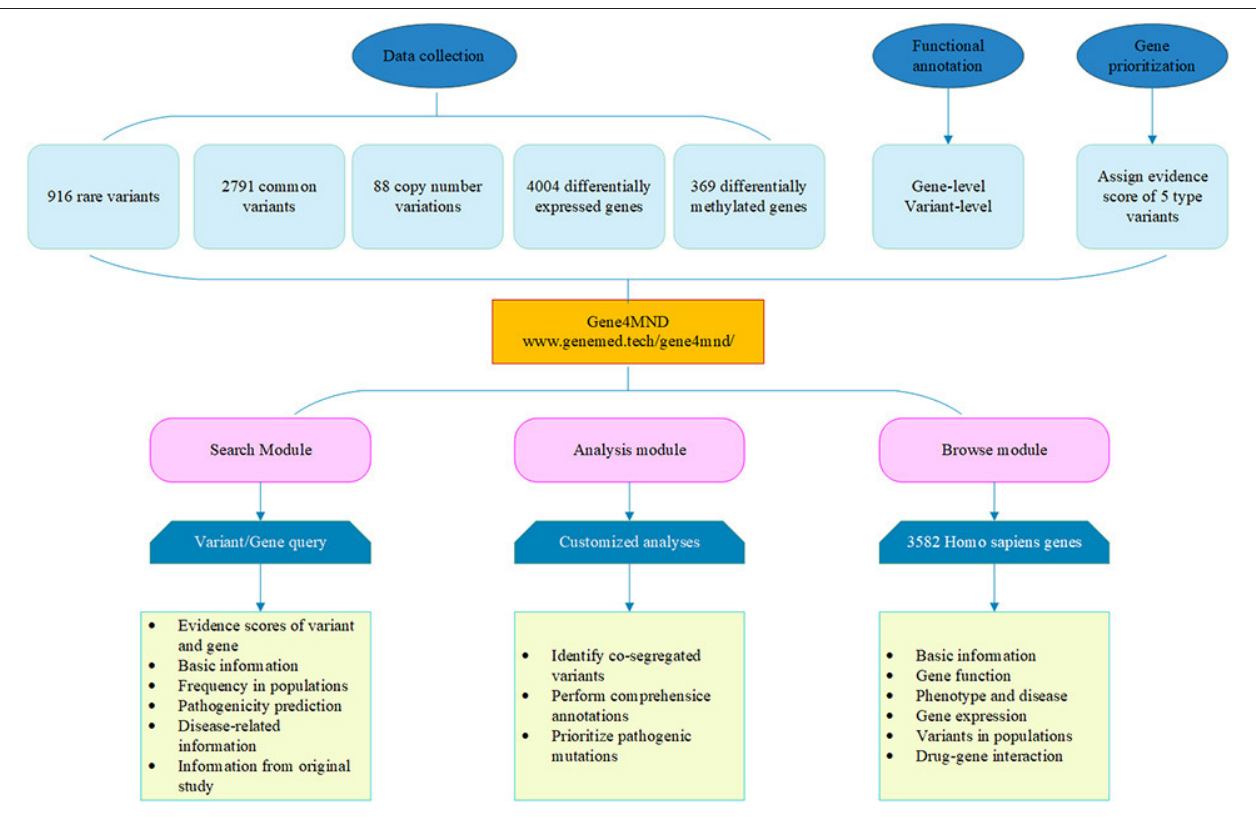
FIGURE 1 | Overview of the Gene4MND database. Multiple types of data from various sources were collected and curated. Systematic data and functional annotation from more 60 genomic data sources were integrated into Gene4MND, which contains three core modules providing comprehensive description information and customized